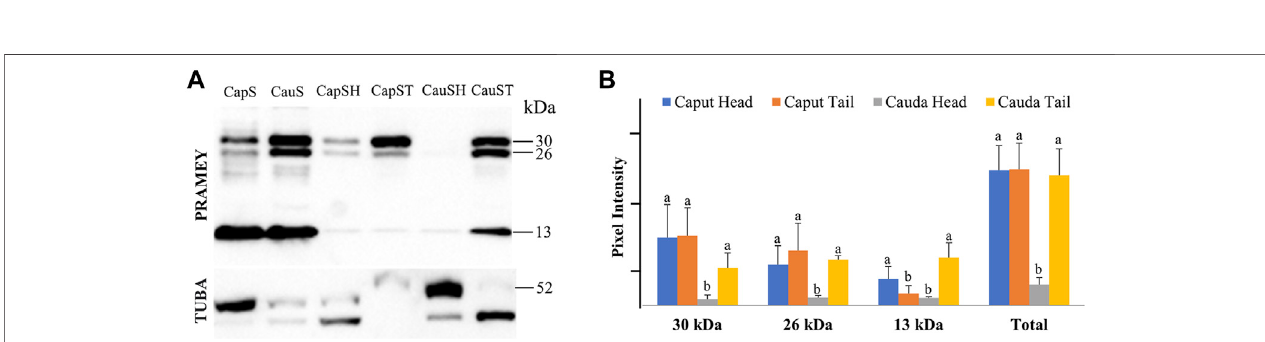
FIGURE 6 | Expression of PRAMEY isoforms in bovine whole caput sperm (CapS), whole cauda sperm (CauS), caput sperm head (CapSH), caput sperm tail (CapST),caudasperm head(CauSH),and cauda sperm tail (CauST) collected fromcaput and cauda segments ofthe epididymis. (A) Immunoblotoftotal sperm protein in each group probed for PRAMEY content and then reprobed for α -tubulin (TUBA). (B) Quanti fi cation of pixel intensities for the 30, 26, and 13 kDa PRAMEY bands, normalizedtothecorrespondingTUBA.Dataareexpressedasthemeanoftheproteindensityintensity±SEM( n =3).Signi fi cancewasevaluatedbetweenthefour types of sperm (caput head, caput tail, cauda head, and cauda tail) for each PRAMEY isoform (30, 26, and 13 kDa). A different letter indicates a signi fi cant difference ( p < 0.05).